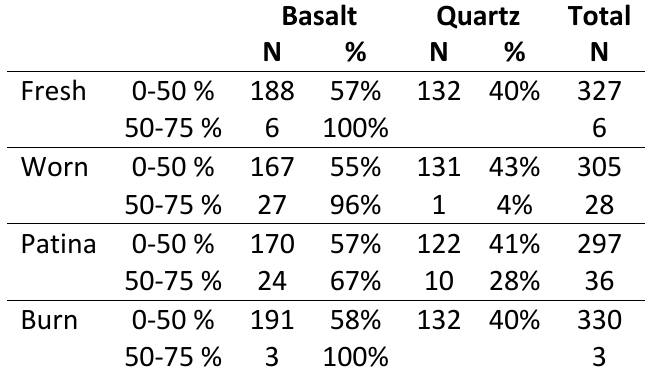
Table 7. GOT 1-S flake operational stages. Preparation Basalt